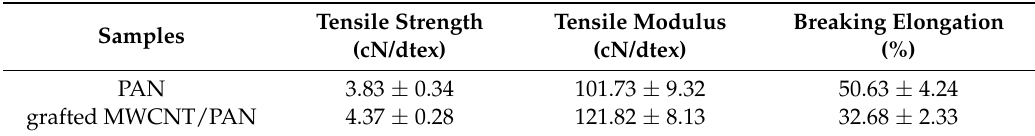
Figure 8. SEM images of cross sectional structure: ( a , b ) the PAN nascent fibers and ( c , d ) the grafted MWCNT/PAN nascent composite fibers. Table 3. The mechanical properties of the PAN nascent fibers and the grafted MWCNT/PAN nascent composite fibers.